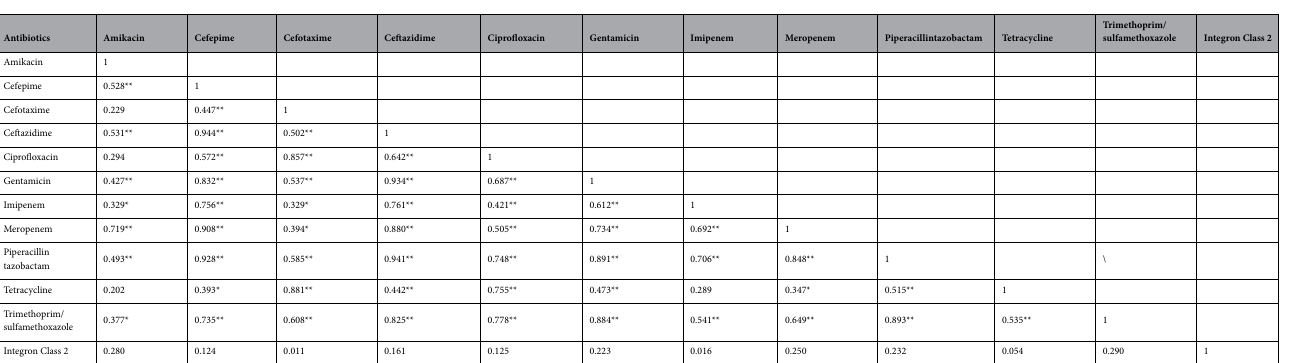
Table 7. Pearson correlation showing a relationship among the antibiotics and class 2 integron in the studied pathogens. **Correlation is significant at the 0.01 level (2-tailed). *Correlation is significant at the 0.05 level